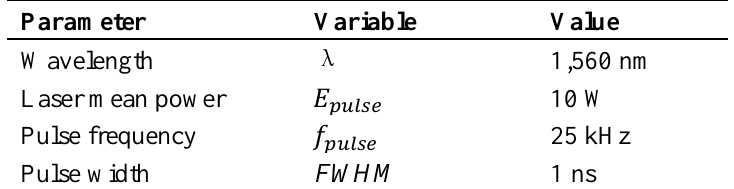
Table 2. Parameters of the laser pulse (related to Equations (17) and (21)).